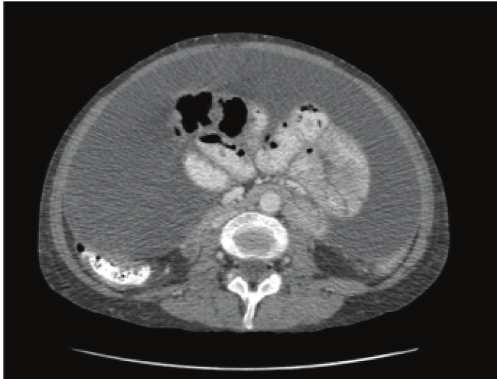
Figure 2: CT abdomen showing ascites and thickened peritoneum (June